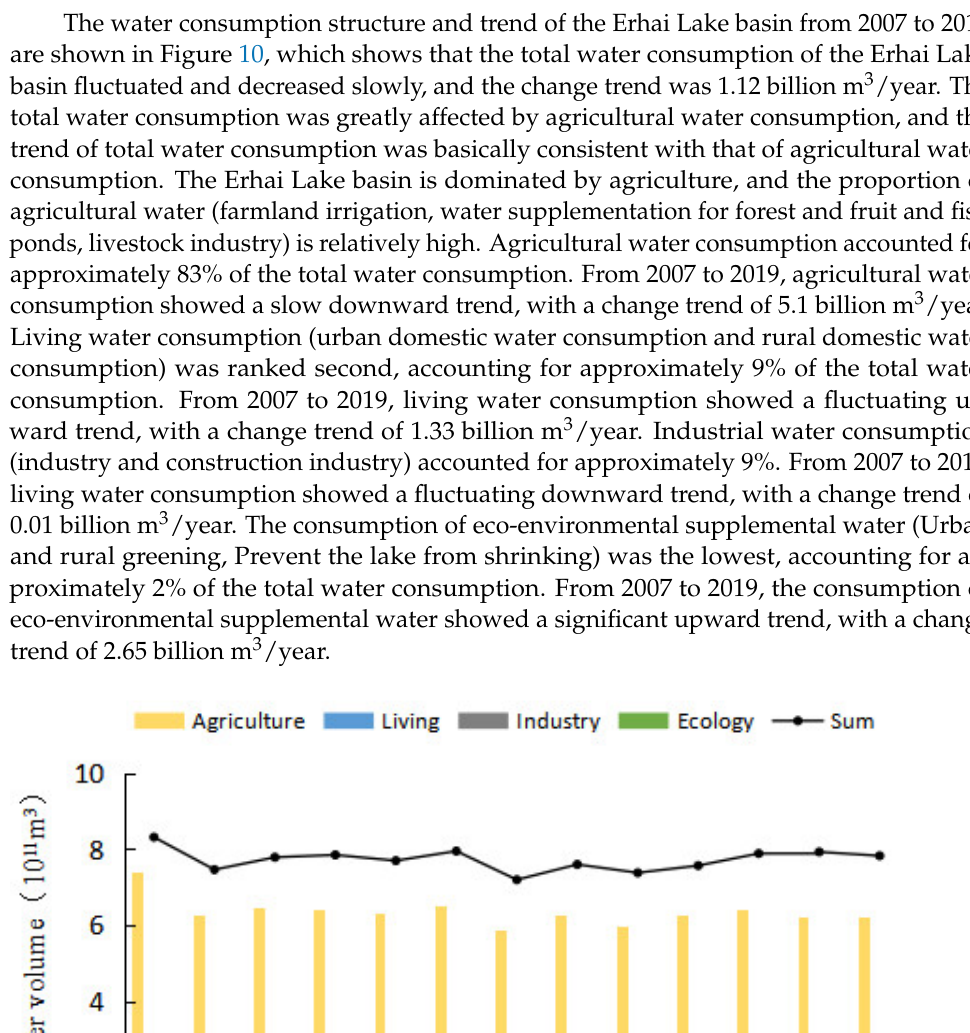
Table 5. Correlation coefficient between different water consumption and water volume.